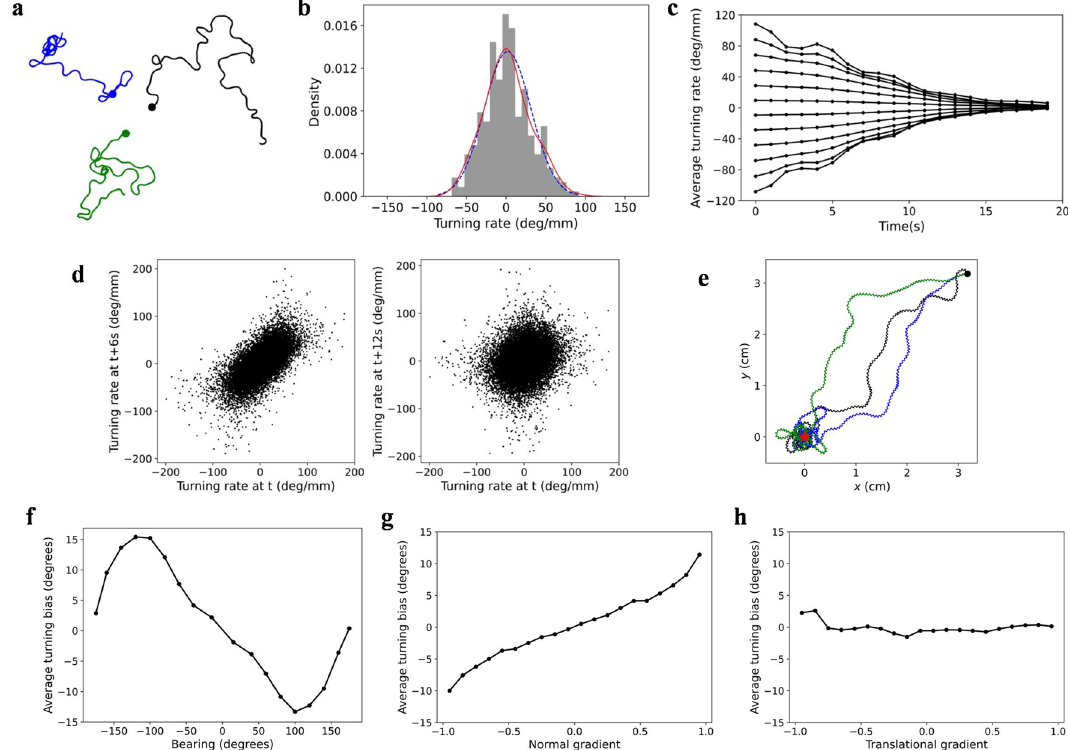
Figure 6. Behavioral analyses of the random-walk model elegans in an isotropic environment ( a - d ) and in an environment with NaCl gradients ( e – h ). ( a ) Three randomly selected tracks. ( b ) Distribution histogram of turning rates in a track ( μ = 1.51 º/mm, σ = 30.52 º/mm, P = 0.38). The blue-dashed line is the probability density curve of the theoretical normal distribution. ( c ) Change in the average turning rates over time. ( d ) Relationship between turning rates at a time t and those after 6 s and 12 s. ( e ) Three randomly selected tracks in the presence of NaCl gradients. The black dot and red star represent the initial position and the NaCl peak, respectively. ( f ) Average turning bias vs. bearing. ( g ) Average turning bias vs. normal gradient. ( h ) Average turning bias vs. translational